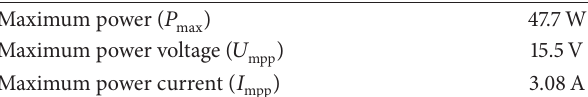
Table 1: Data sheet of KC65T at 800 W/m 2 , 25 ∘ C.